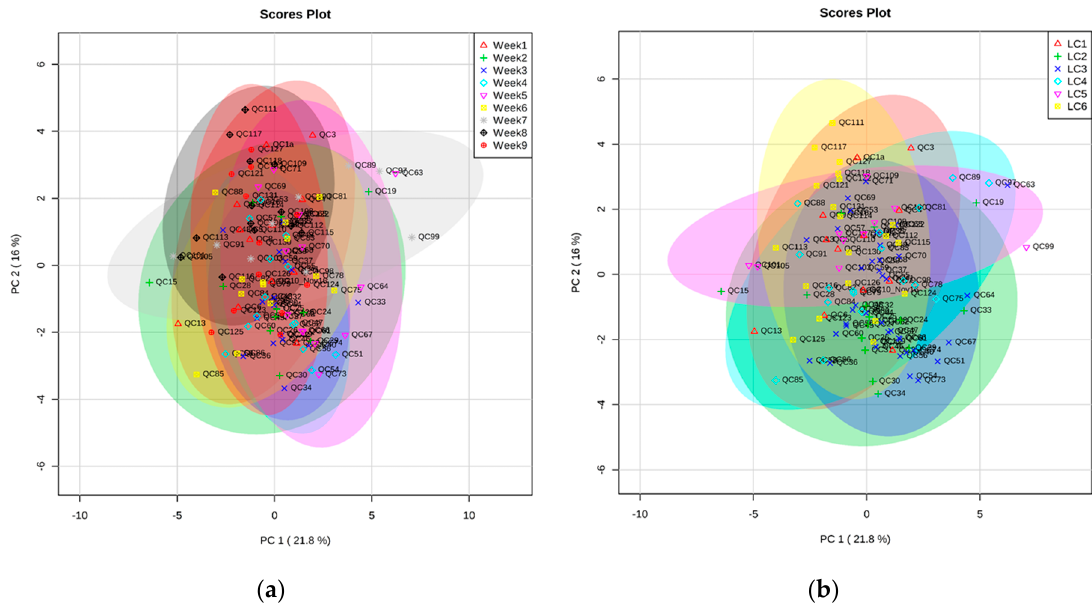
Figure 2. Two dimensional projections of Principal Component Analysis (PCA) using 23 major metabolites identified using automatic trimetylsilil (TMS) derivatisation of plasma samples. Here, LC denotes the GC inlet liner change. ( a ) week to week variation; ( b ) GC inlet liner change.